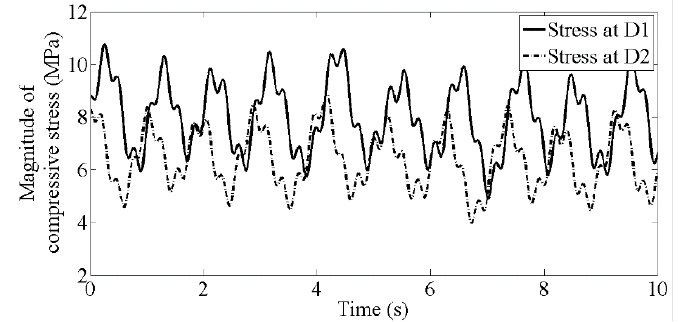
Figure 14. Vertical stresses at D1 and D2 at a mean wind speed of 14 m/s.